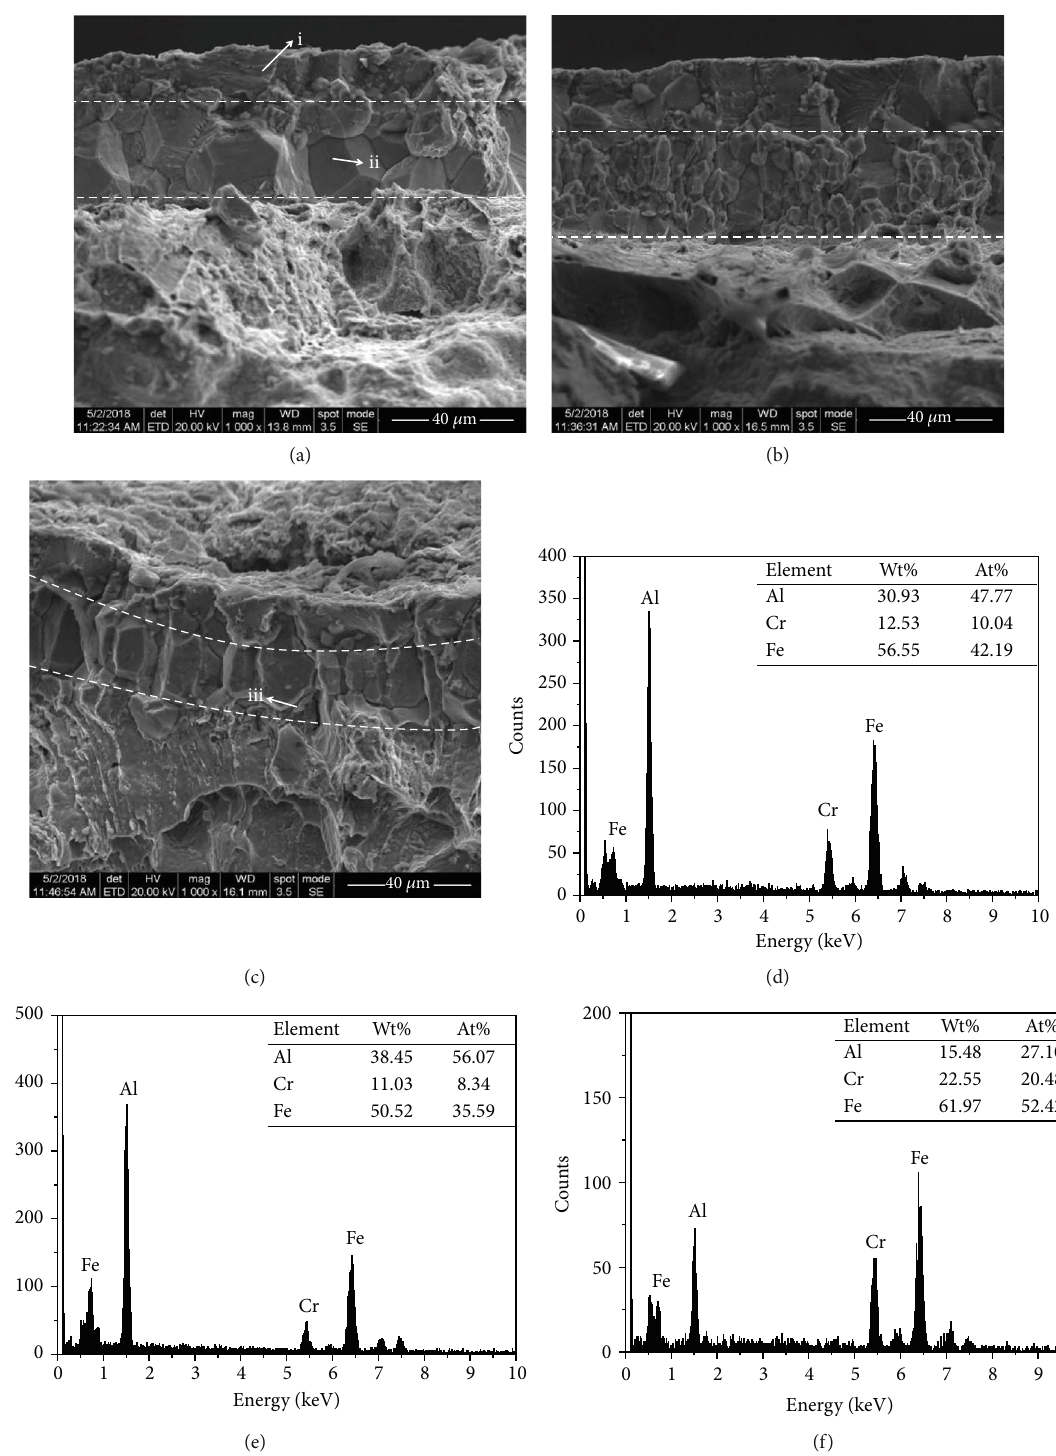
Figure 9: SEM morphology and EDS analysis of fracture surfaces: (a) aluminized steel; (b) aluminized steel with single LSP impact; (c) aluminized steel with three LSP impacts; (d) EDS spectrums of point i in (a); (e) EDS spectrums of point ii in (a); (f) EDS spectrums of point iii in